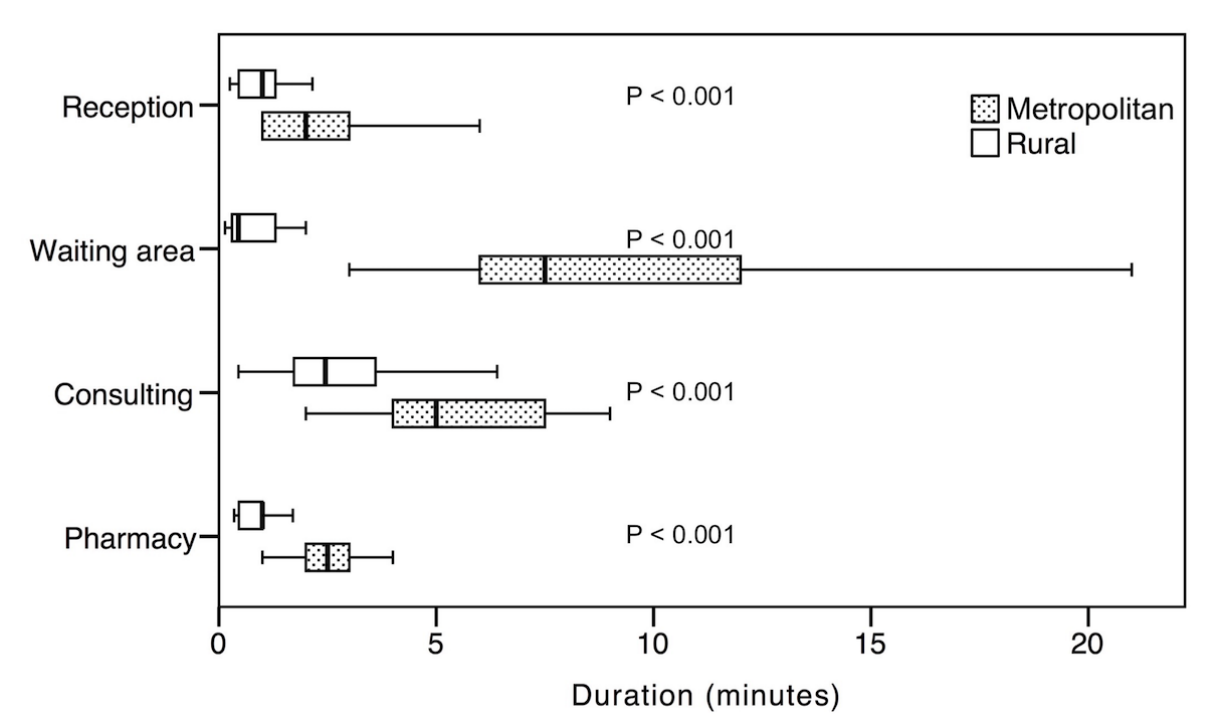
Figure 2. The time spent performing tasks at primary health care centers in metropolitan and rural